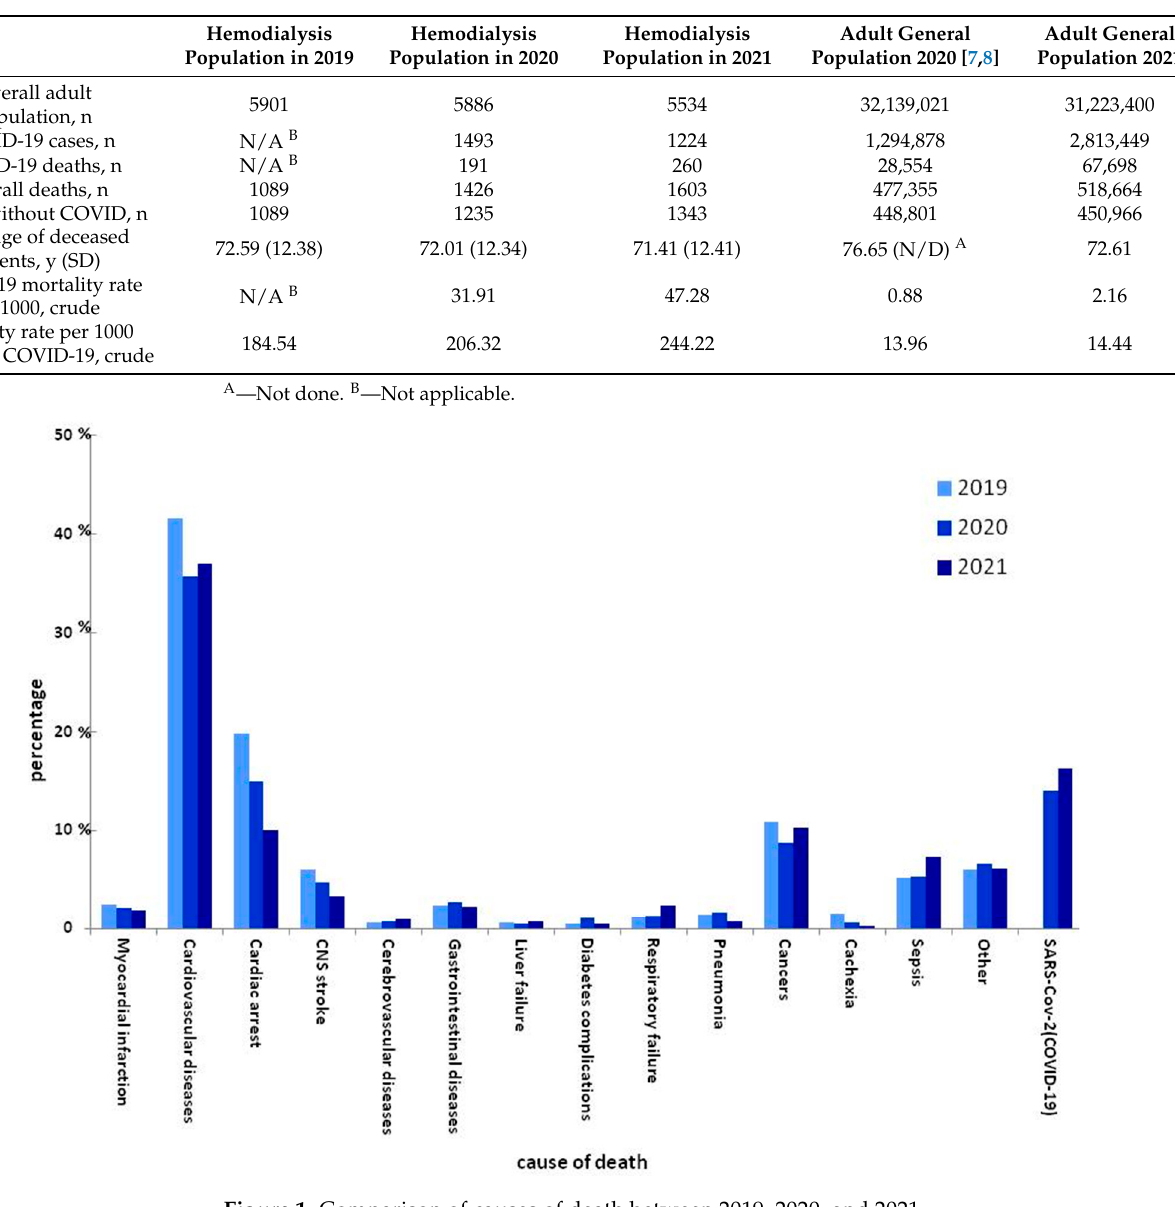
Figure 1. Comparison of causes of death between 2019, 2020, and 2021. Table 1. Comparison of the mortality rate in hemodialyzed patients in 2019, 2020, and 2021 and in